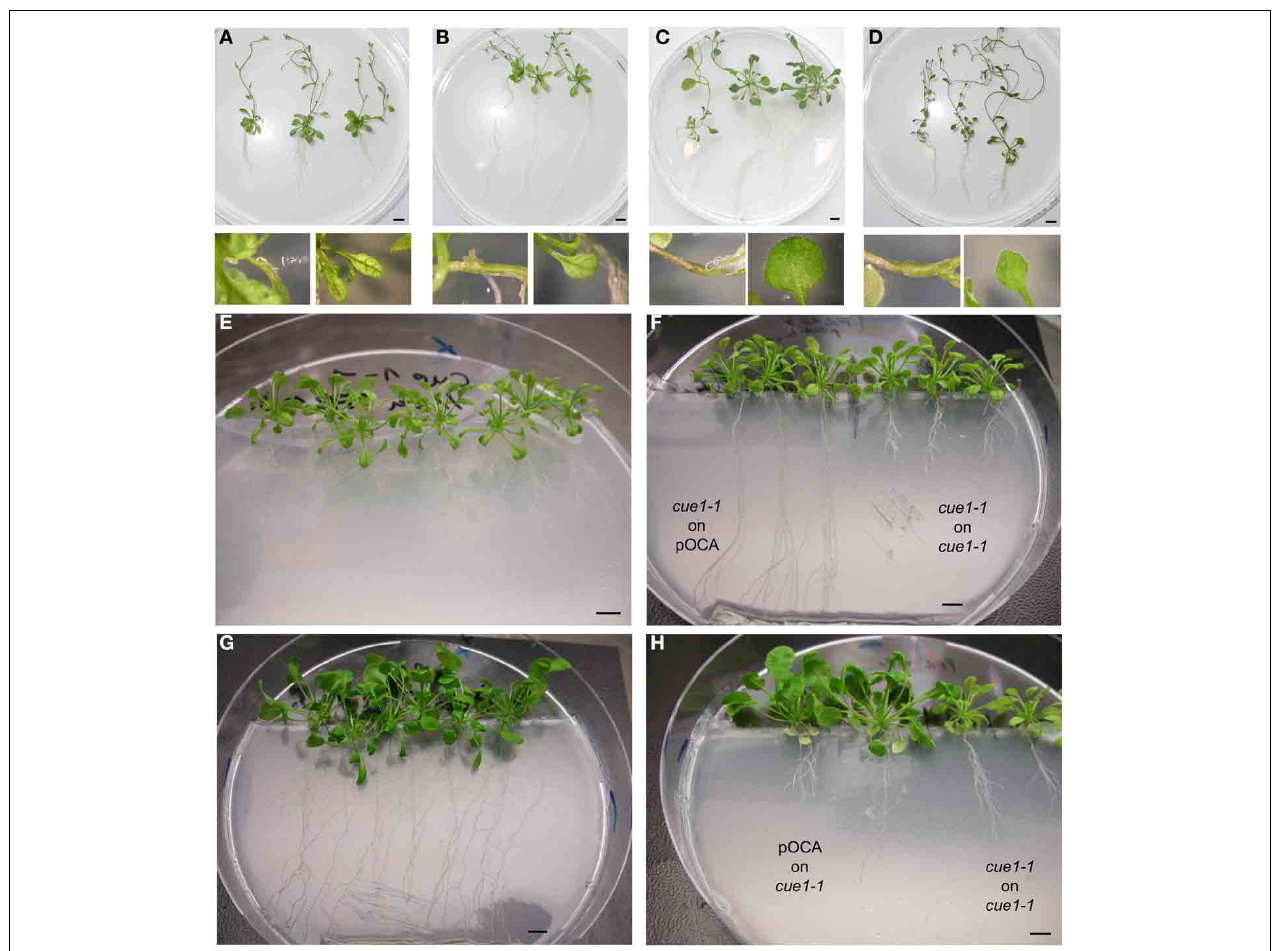
FIGURE 2 | Development of the cue1-1 shoot and root phenotypes does not require communication between roots and shoots. Different scion|root stock combinations of cue1-1 and pOCA (Bensheim) are shown from two independent grafting experiments. (A) cue1-1 | cue1-1 (mutant control), (B) cue1-1 |pOCA (C) , pOCA|pOCA (wild type control), (D) pOCA| cue1- . Pictures